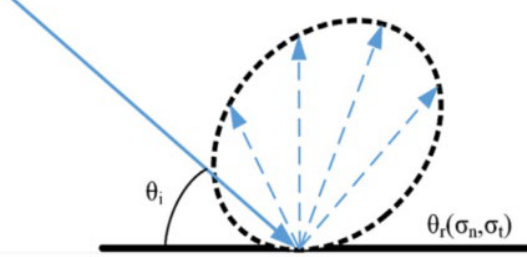
Figure 1. Reflection velocity distribution of wall impact molecules described by CLL model.